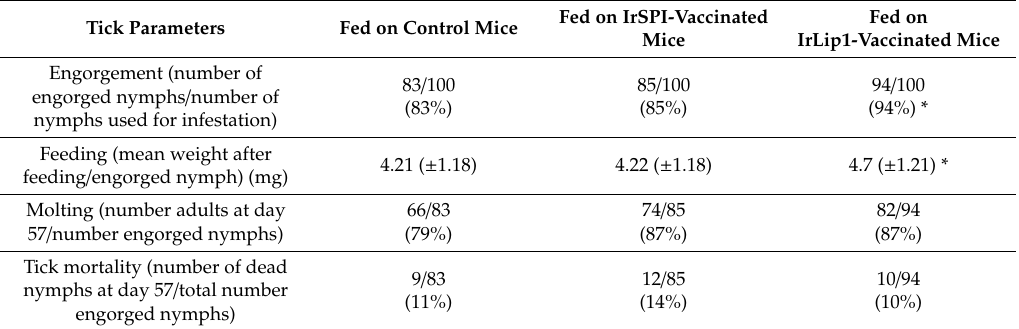
Table 1. Effect of vaccination of mice with recombinant IrSPI and IrLip1 proteins on tick infestation parameters.